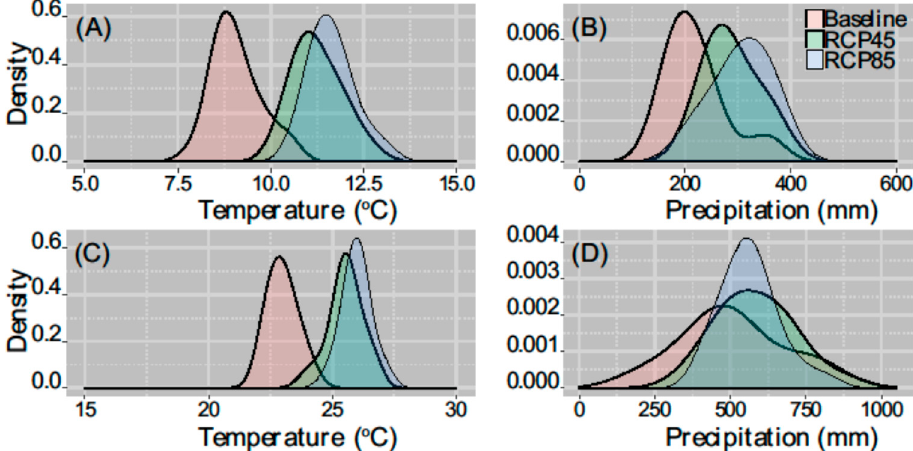
Figure 1. Frequency distributions of ( A , C ) temperature and ( B , D ) average accumulated precipitation for the winter wheat and summer maize growing seasons for the baseline (1981–2010), RCP4.5, and RCP8.5 climate scenarios. The mean value for the RCP4.5 and RCP8.5 climate scenarios was averaged from three general circulation models: BCC-CSM1.1 (m), CSIRO-Mk3.6.0, and HadGEM2-AO.